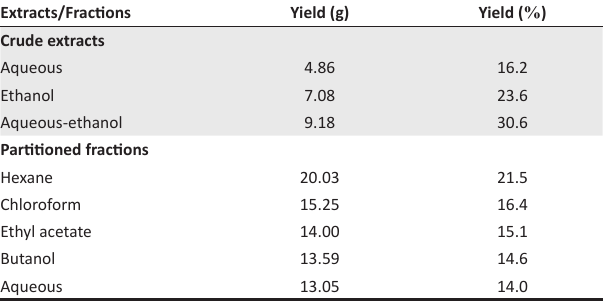
TABLE 1: Yield of crude extracts and partitioned fractions of E. elephantina root. Extracts/Fractions